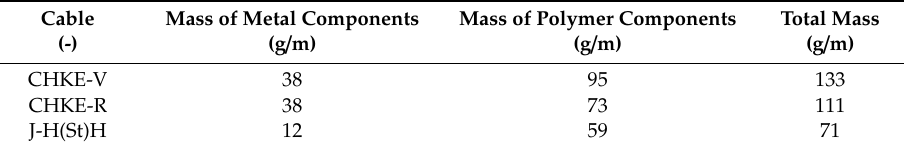
Table 2. Mass of metal and polymer components per unit length of cable examined.